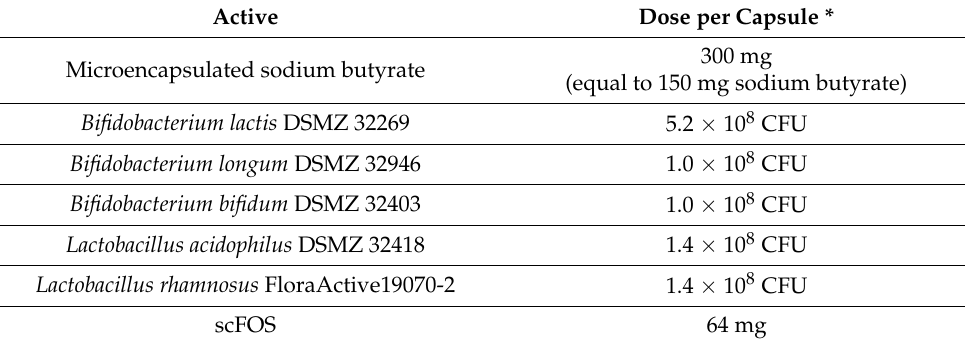
Table 1. Composition and doses of the individual components of the product administered to patients. Active Dose per Capsule * 300 mg Microencapsulated sodium butyrate (equal to 150 mg sodium butyrate) Bifidobacterium lactis DSMZ